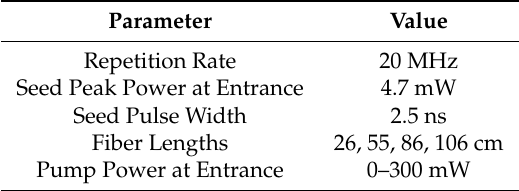
Table 2. The experimental parameters used for characterizing the